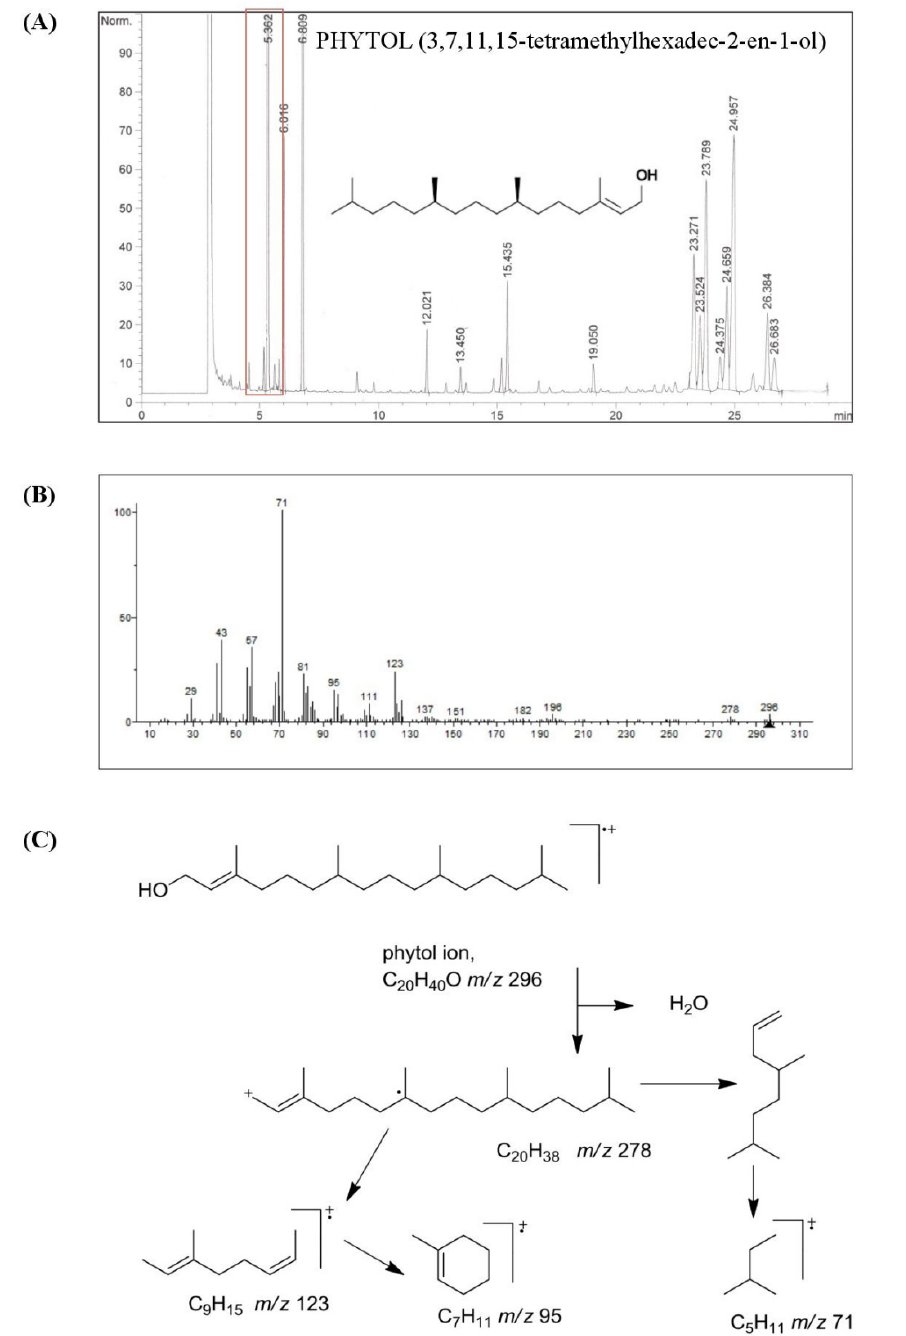
Figure 1. Characterization of phytol isolated from HSO. ( A ) Gas chromatogram of acyclic aliphatic alcohols, triterpene alcohols, and 4-methylsterol fractions of unsaponifiable HSO and chemical structure of phytol (3,7,11,15-tetramethylhexadec-2-en-1-ol). ( B ) Mass spectrum and ( C ) schematic representation of the phytol mass fragmentation pattern.